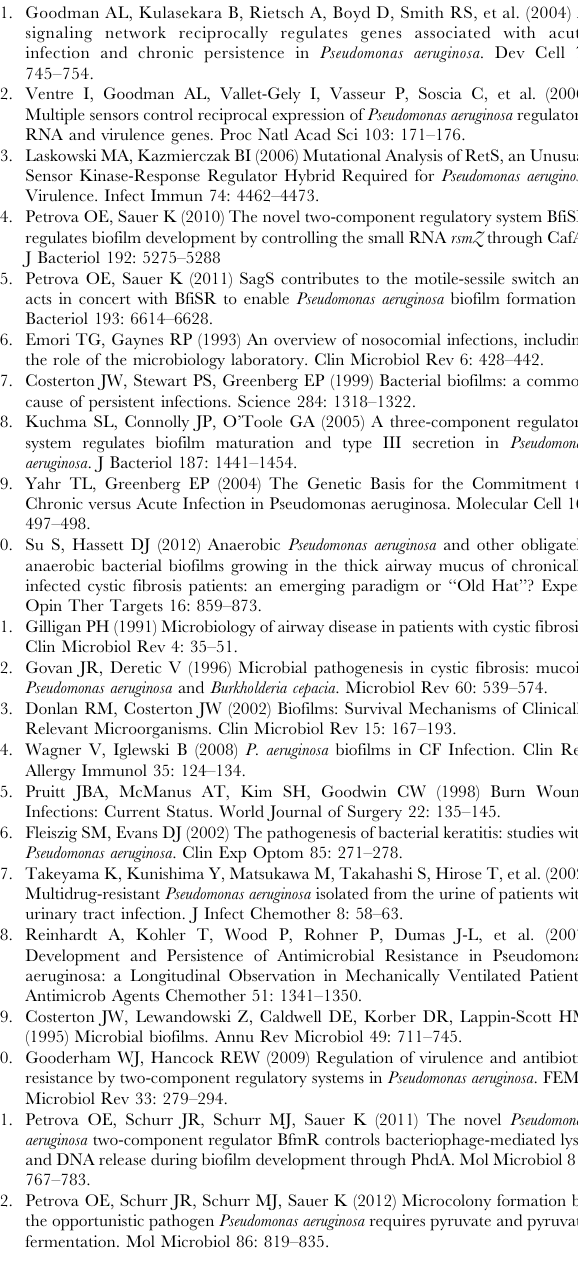
Table S2 Bacterial strains and plasmids. Table S3 Primers